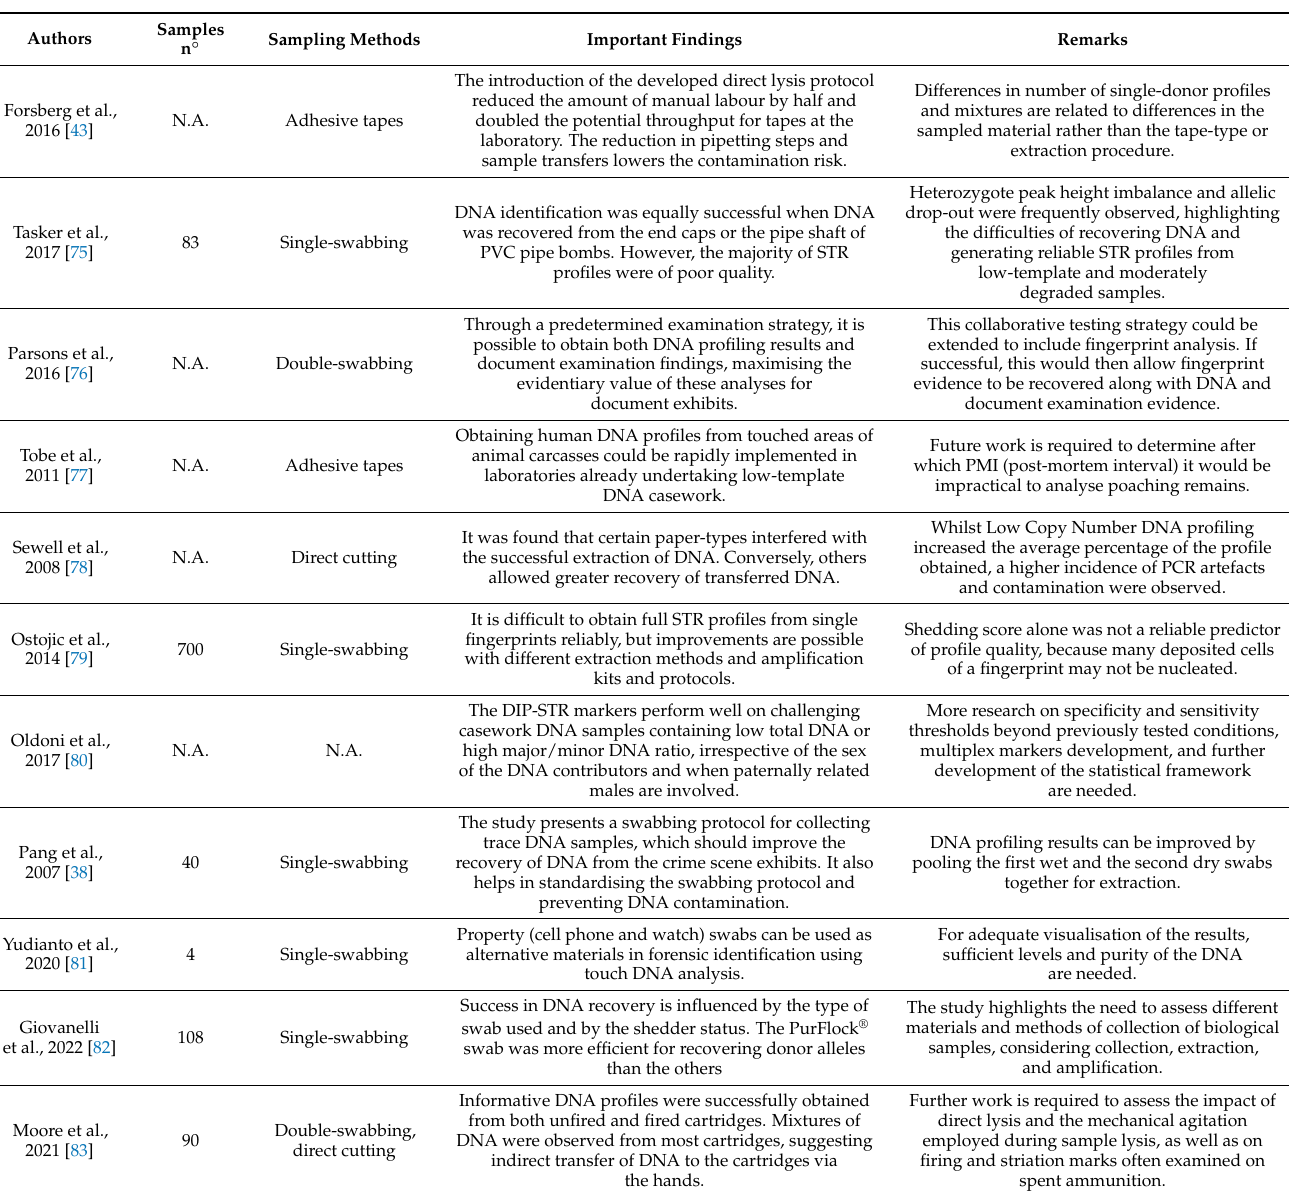
Table 4. Papers categorized in Group 3b. Features displayed are authors and publication